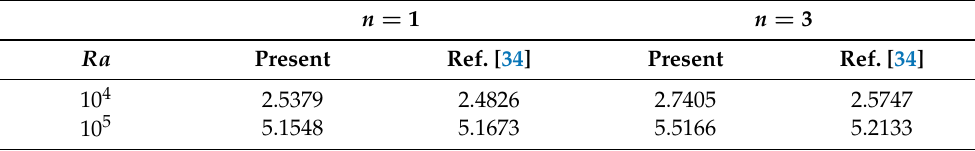
Table 3. Comparison of average Nu values in the case of NC flow of an NF in a wavy cavity. n = 1 n = 3 Ra Present Ref. [34] Present Ref. [34] 10 4 2.5379 2.4826 2.7405 2.5747